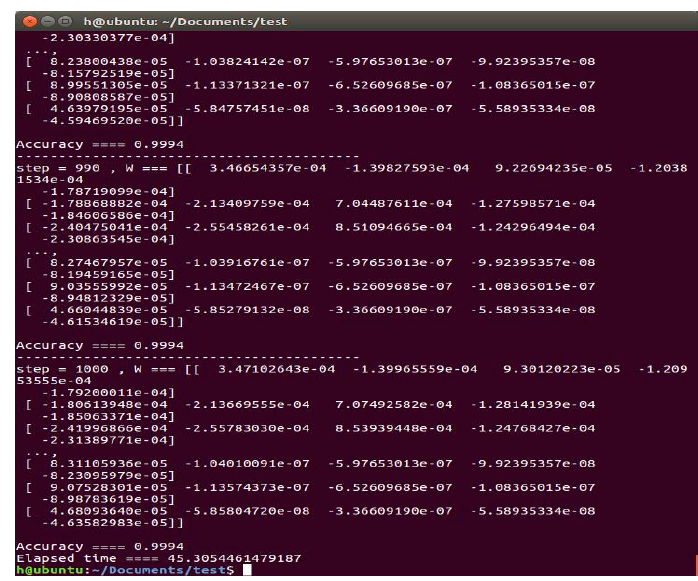
Figure 12. Accuracy and time of G-Descent in 5 cases. Electronics 2020 , 9 , x FOR PEER REVIEW